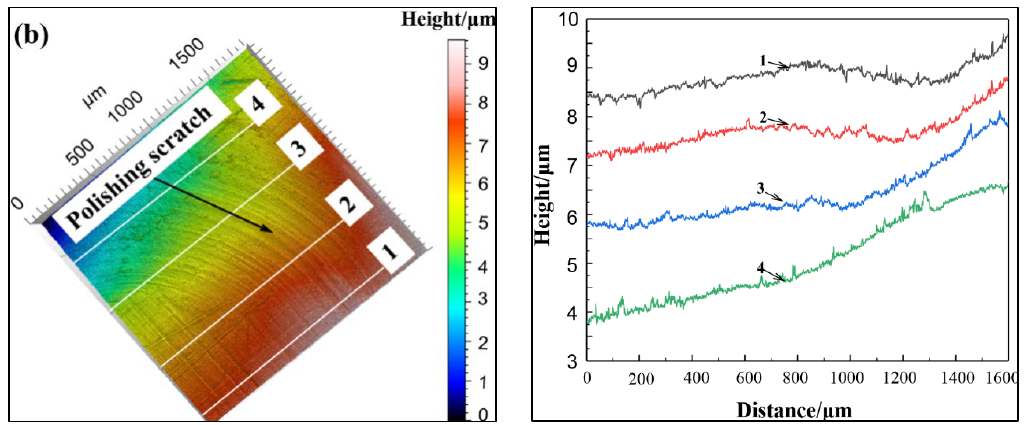
Figure 11. 3D morphology of the friction surface with the modified coatings before and after the addition of the rare earth oxide CeO 2 : ( a ) unmodified coating and ( b ) 1.0% CeO 2 .